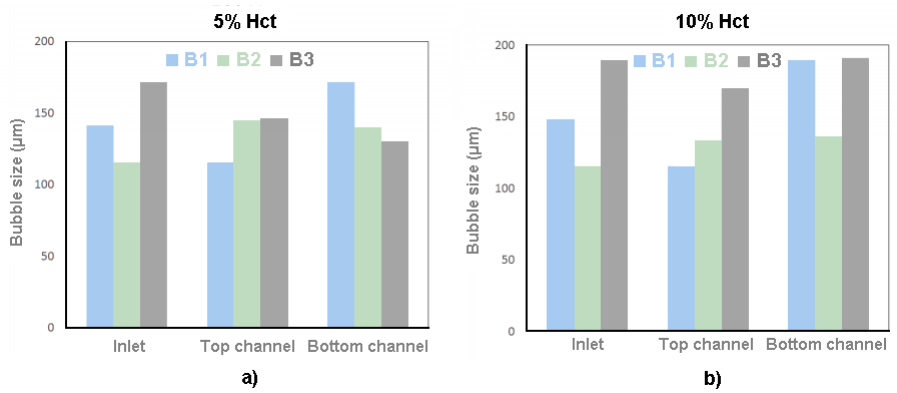
Figure 12. Bubble size for ( a ) case 1, 5% Hct, and ( b ) case 2, 10% Hct .